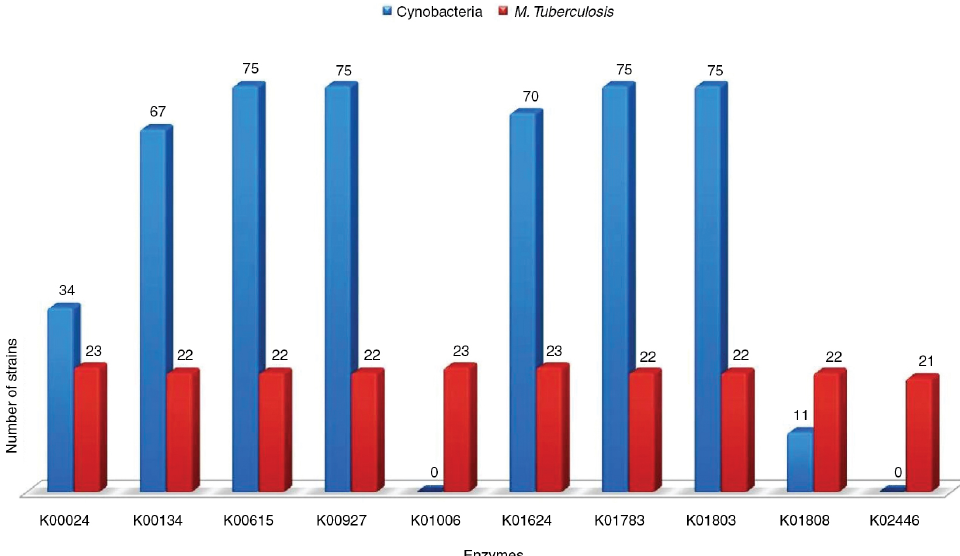
Figure 1: The comparison of CO fixation pathway enzymes (ko00710) between M. tuberculosis and Cyanobacteria. The 2 comparison showed that Cyanobacteria shared eight enzymes with M. tuberculosis